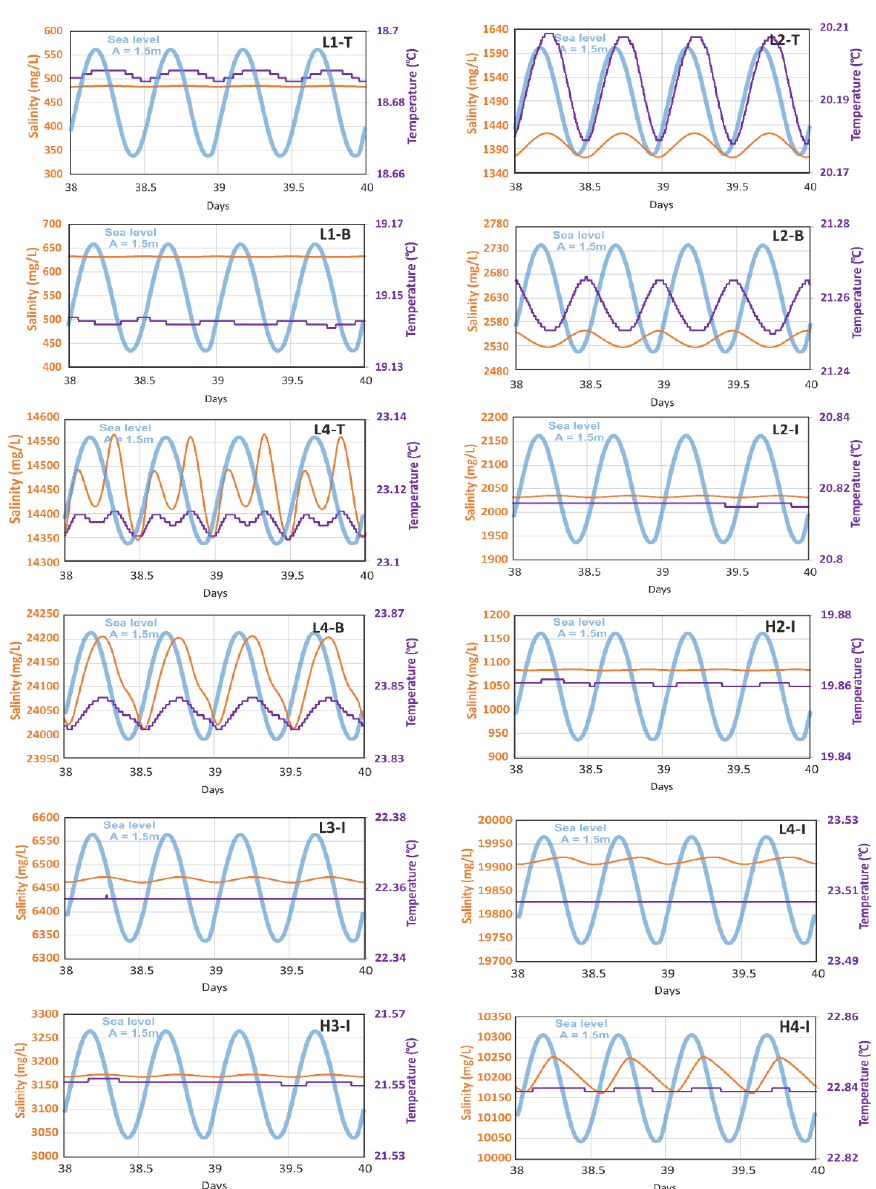
Figure A1. Simulation results of model B at different depths of the well W for a mesotidal condition (semi-amplitude of 1.5 m).